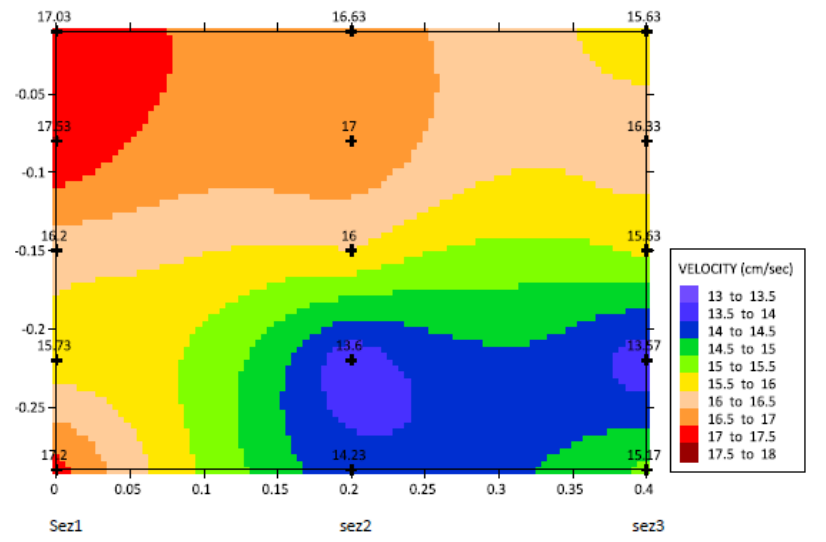
Figure 10. Distribution of predicted velocities on the three sections of the channel: at the beginning (sez1), the middle (sez2), and the end (sez3).